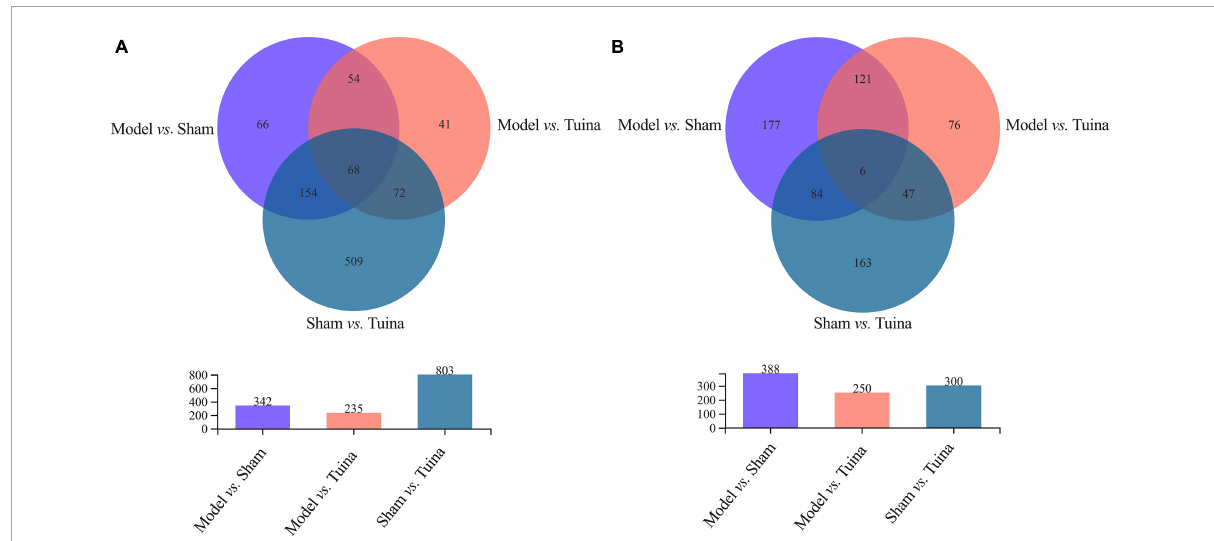
FIGURE5 Results of the Venn analysis, the abscissa is the group, and the ordinate is the number of DEGs. (A) DRG sequencing; (B) SDH sequencing. The overlapping regions are identically expressed genes, and genes in the overlapping regions of model vs. sham and model vs. tuina are associated with the therapeutic effects of tuina.